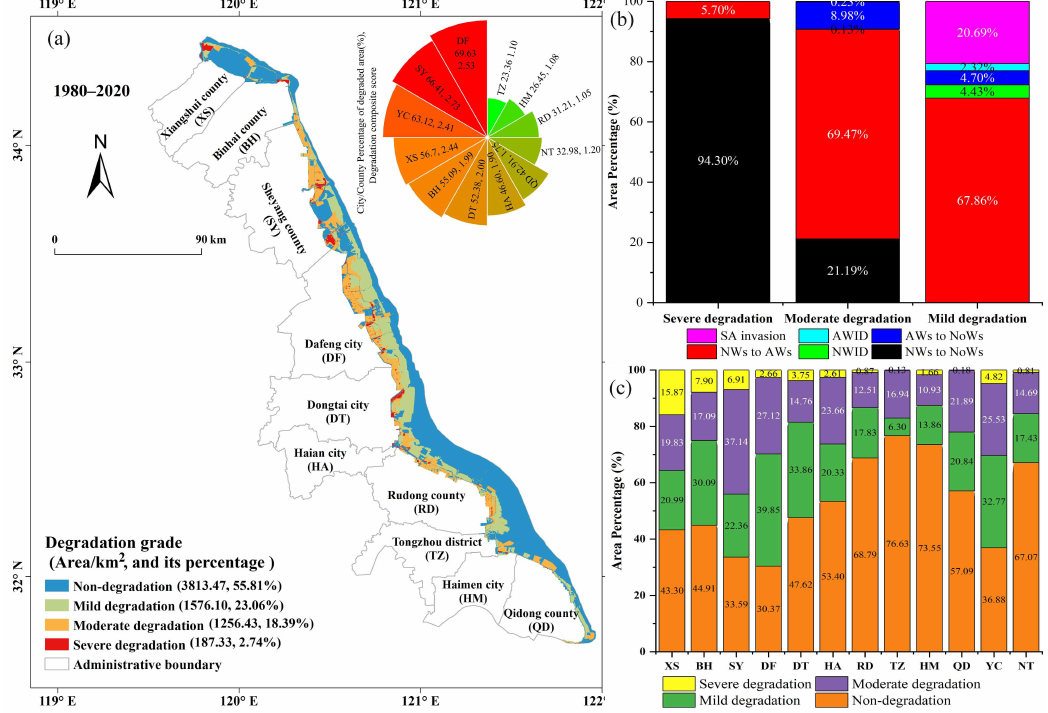
Figure 6. Degradation levels of coastal wetlands in different administrative units in Jiangsu during 1980–2020. ( a ) Spatial distribution of degradation grades; ( b ) Percentage of area occupied by each landscape transformation type in different degradation grades; ( c ) Percentage of area of different degradation grades in each